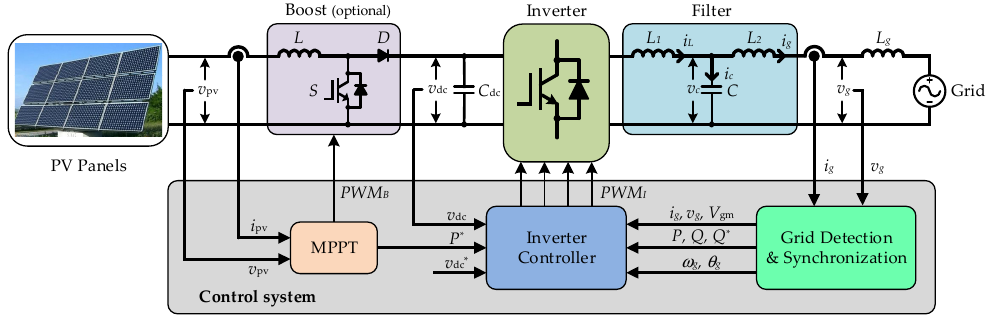
Figure 1. Generic control structure of the single-phase grid-connected photovoltaic (PV) system. Maximum power point tracking (MPPT).